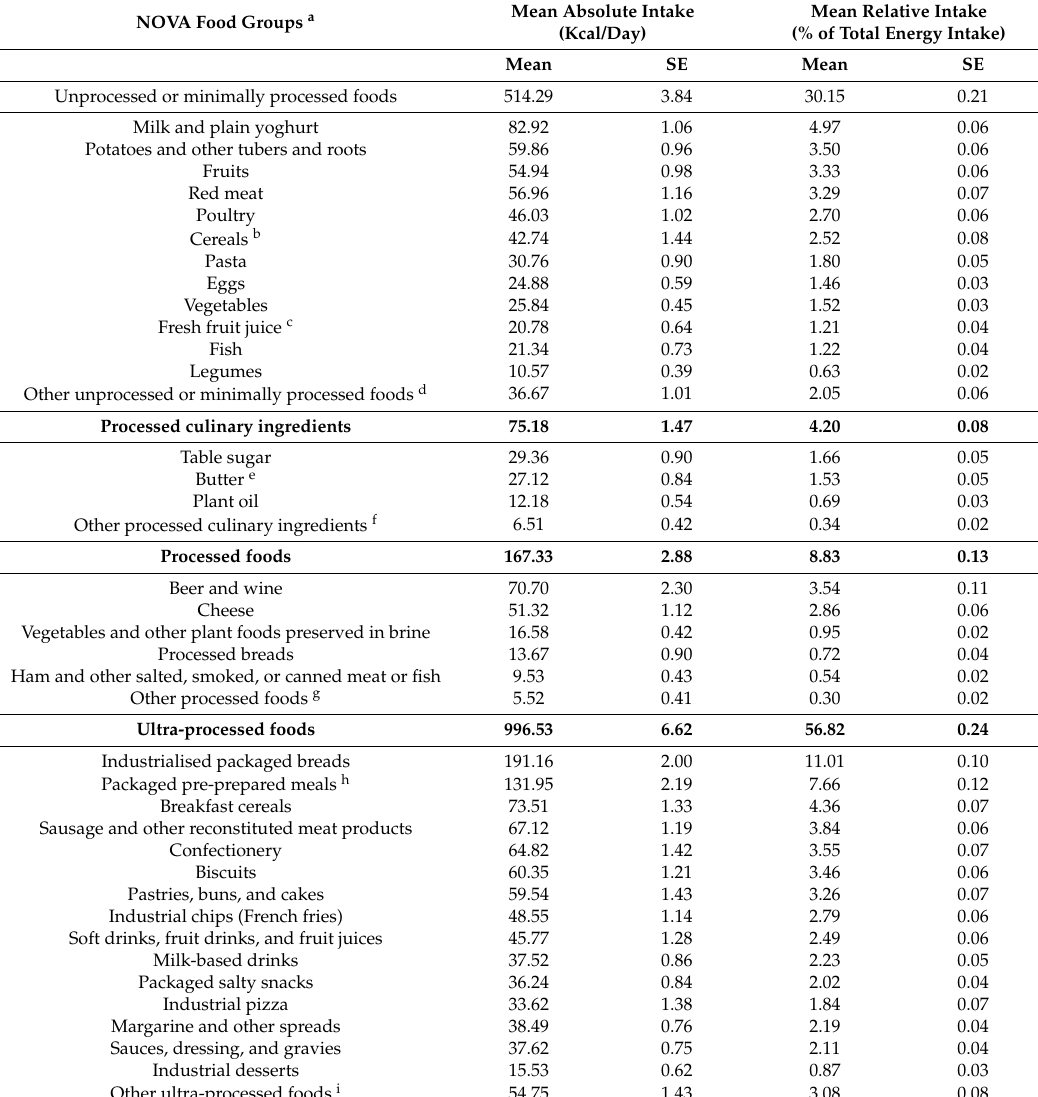
Table 1. Distribution of total energy intake according to NOVA food groups. U.K. population aged 1.5 years or over